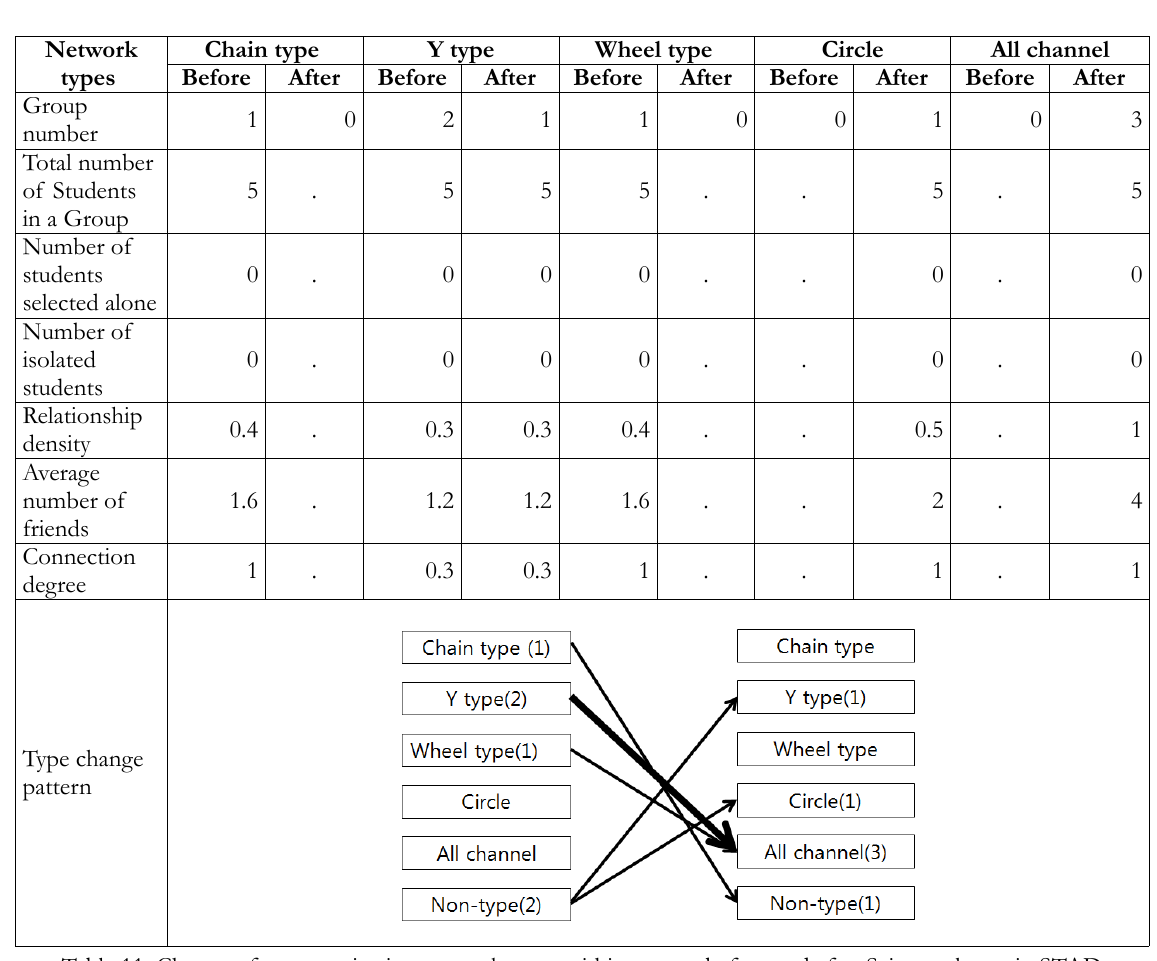
Table 11. Change of communication network types within groups before and after Science classes in